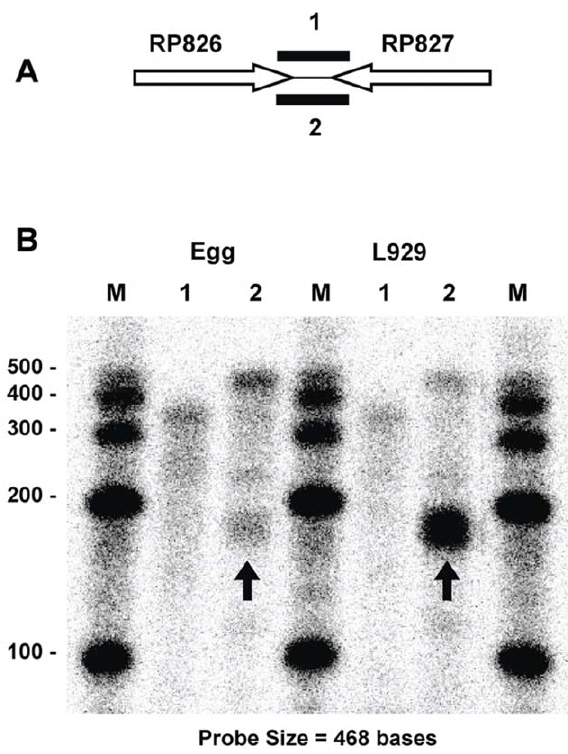
Figure 3. RPA analysis identifying transcripts of the RP826- RP827 intervening region. (A) Schematic indicating the relative position of the RPA probes that span the intergenic region. Probe 1 is designed to hybridize to RP826 transcripts while probe 2 hybridizes to RP827 transcripts. (B) RPA analysis of rickettsial RNA isolated from rickettsiae grown in egg yolk sacs or in L929 cells. Lane numbers correspond to probe numbers in the schematic. M, sized markers with sizes (in bases) indicated. The marker lane on the right was digitally moved horizontally using Microsoft Office PowerPoint to maintain consistent lane organization. Arrows identify the band resulting from termination of RP837 transcripts at the predicted terminator.